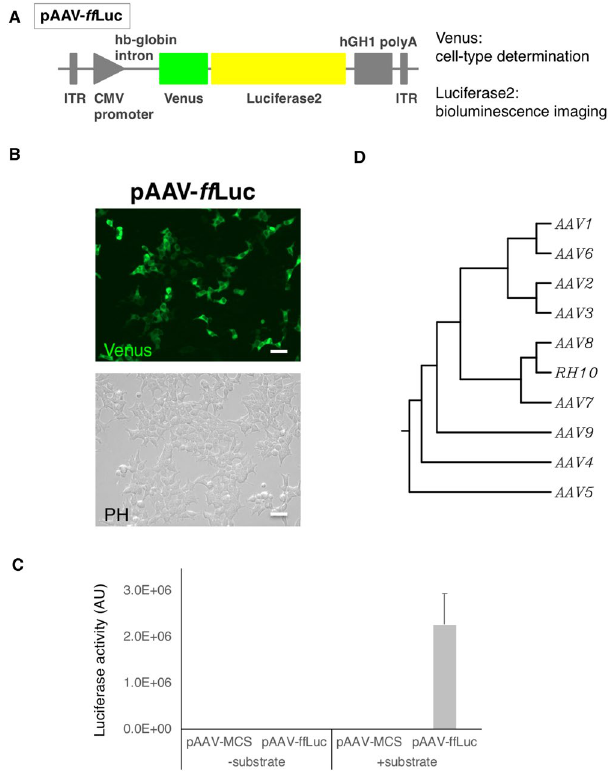
Figure 1. Establishment of a reporter system for analysing the cell type-specific tropism of AAV. ( A ) Diagram of the AAV vector. The Venus-luciferase 2 reporter gene cassette ( ff Luc-cp156: ff Luc) was used and inserted into pAAV-MCS, which contains AAV2 ITRs, the CMV promoter, the human β -globin intron and the human growth hormone polyadenylation signal. ( B ) Representative phase contrast and fluorescence images of HEK293T cells after transient transfection of pAAV- ff Luc. Scale bars, 50 μ m. ( C ) Luciferase activity of HEK293T cells after transfection of pAAV- ff Luc. Luciferase activity was observed only in the cells transfected with pAAV- ff Luc. ( D ) Phylogenetic analysis based on the amino acid sequence of the VP1 capsid protein for each